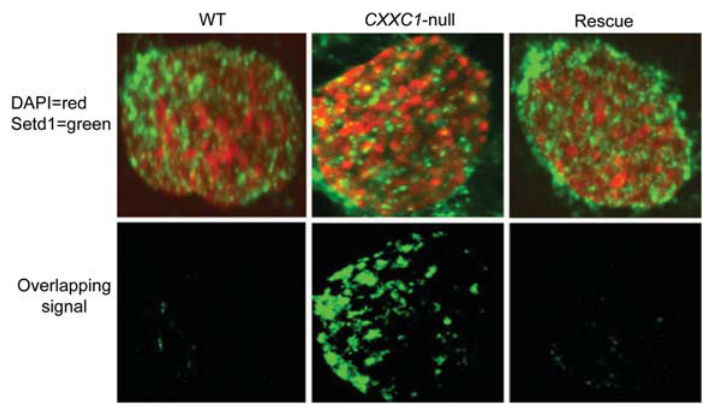
Figure 2 Cfp1 is required to restrict Setd1A protein to euchromatin. Confocal microscopy was utilized to assess the subnuclear distribution of the Setd1A protein in wild-type (WT), CXXC1 -null, or rescued ( CXXC1 -null cells transfected with a Cfp1 expression vector) murine ES cell lines. The top row illustrates the relative subnuclear distribution of Setd1A (green) and DAPI-bright heterochromatin (red). Colocalization is indicated by a yellow or orange color. The bottom row reveals the extent of overlapping signal (displayed in green).